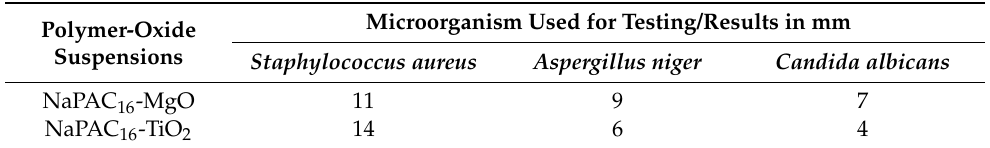
Table 4. Growth inhibition zone of tested microorganisms around polymer-oxide suspensions.